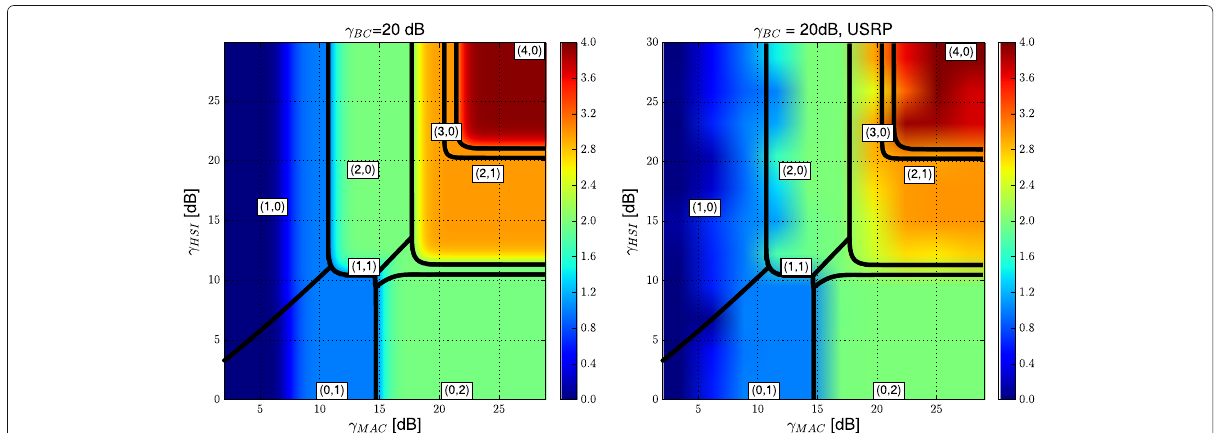
Fig. 11 Comparison of T LB and the throughput performance evaluated in a real-world adaptive HW setup ( T USRP ) for γ BC = 20dB. The SNR mapping , N I s )) used in the HW evaluation are also emphasized in the figure regions (including the optimal const. parameters ( N I b